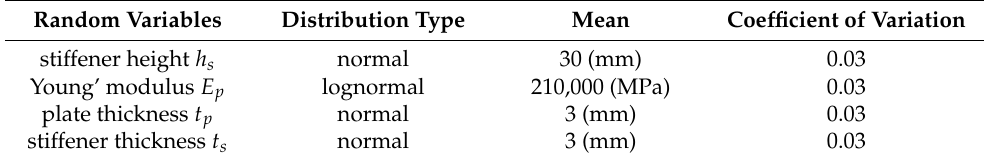
Table 2. Distribution and parameters of random variables.